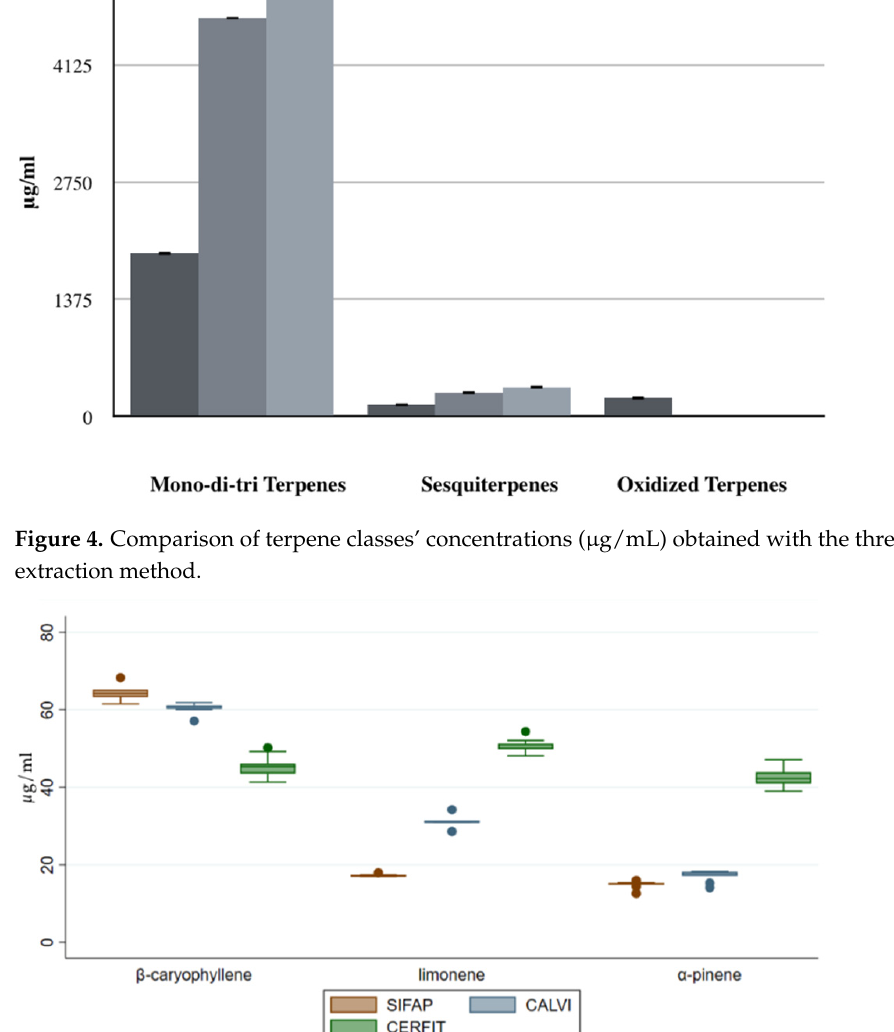
Figure 5. Distribution of concentrations of β -caryophyllene, limonene and α -pinene in medical Can- nabis oil preparations extracted by three different methods.